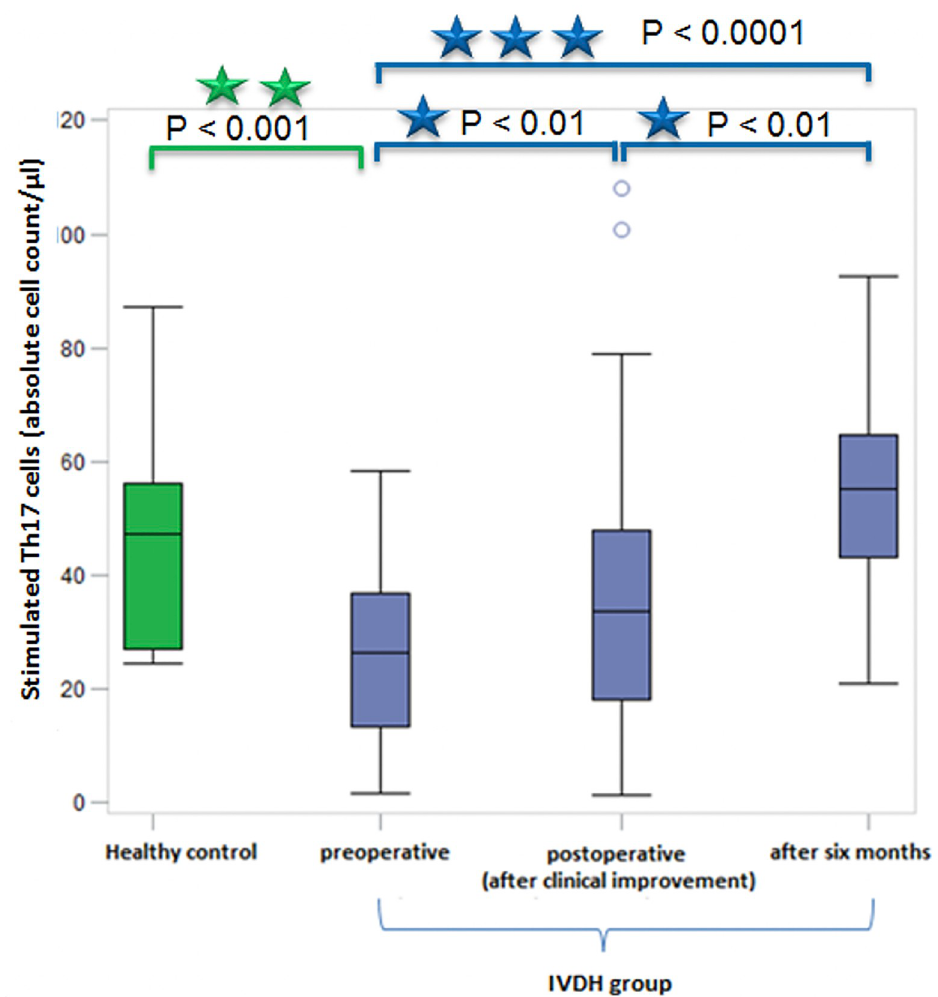
Fig 4. Significant differences between Th17-cell levels of dogs suffering from IVDH at all three sampling time points and in comparison with the healthy control group. Highly significant differences between preoperative Th17-cell levels and control after six month ( ��� p < 0.0001). Significant differences between preoperative and postoperative Th17-cell levels and also between postoperative and after six month control Th17-cell levels ( �� p < 0.01). The difference between preoperative Th17-cell levels of dogs suffering from IVDH and healthy control group was high significant. ��� : Highly significant (p < 0.0001); �� : High significant (p < 0.001); � : Significant (p < 0.01). Green boxplot: Healthy control group; Blue boxplots: IVDH group sorted by measurement time; Sample number: Healthy control group: n = 10; IVDH group: n = 137 (preoperative: n = 62; postoperatively: n = 55; after six month: n = 20). Th17 cells: T-helper 17 cells; IVDH = intervertebral disc herniation; μ l: microliters. group n = 17; healthy group n = 10) for IL-17 assessment. All samples were analyzed by using Enzyme linked immunosorbent assays (ELISA) simultaneously.